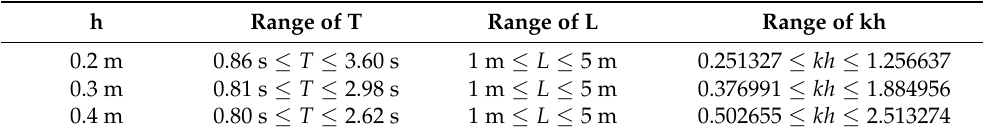
Figure 1. Schematic numerical model setup for regular wave over periodically submerged breakwater ( N = 2). Table 1. Wave parameters at different water